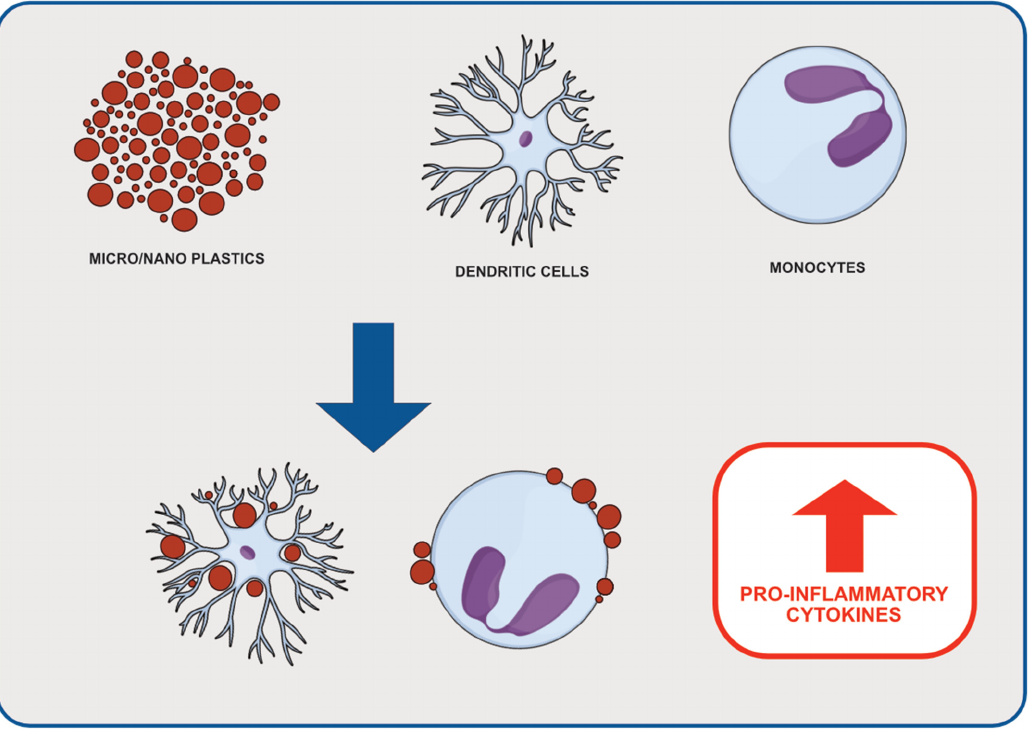
Figure 2. Effects of micro- and nanoplastic on inflammatory cells. Micro- and nanoplastics binding to cells such as dendritic cells or monocytes might stimulate the release of pro-inflammatory cytokines.